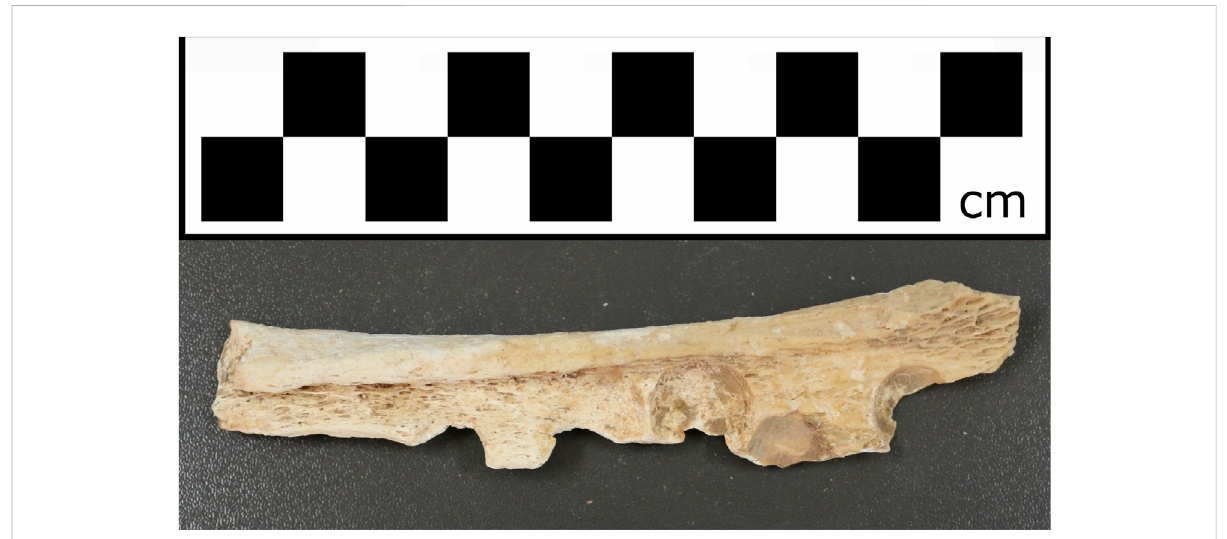
FIGURE 5 Fragment of an oracle bone from Sunjia, made out of a large mammal ’ s scapula.